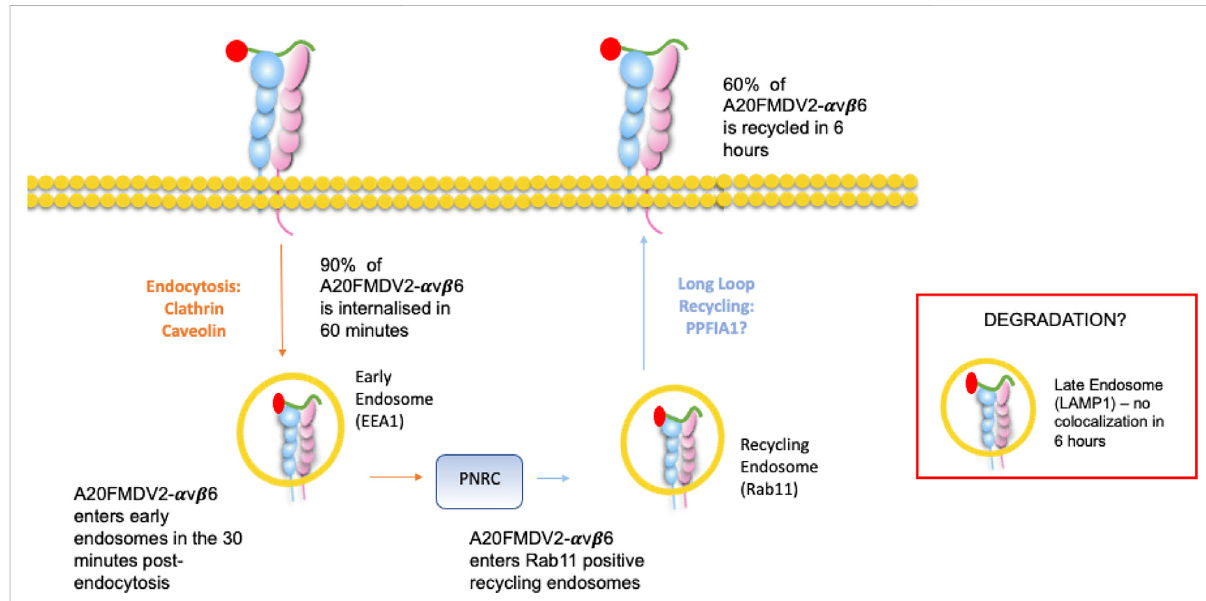
FIGURE 7 Ligand-bound endocytosis and traf fi cking of α v β 6 Summary fi gure for this study. A20FMDV2- α v β 6 internalises by clathrin and caveolin mediated endocytosis into early endosomes, where it colocalises with EEA1 in the fi rst 30 min post endocytosis. From the early endosome, A20FMDV2- α v β 6 accumulates in perinuclear clusters, which are positive for Rab11 (1 – 6 h post endocytosis). Within this 6-h time frame, 60% of internalised A20FMDV2- α v β 6 is recycled back to the cell